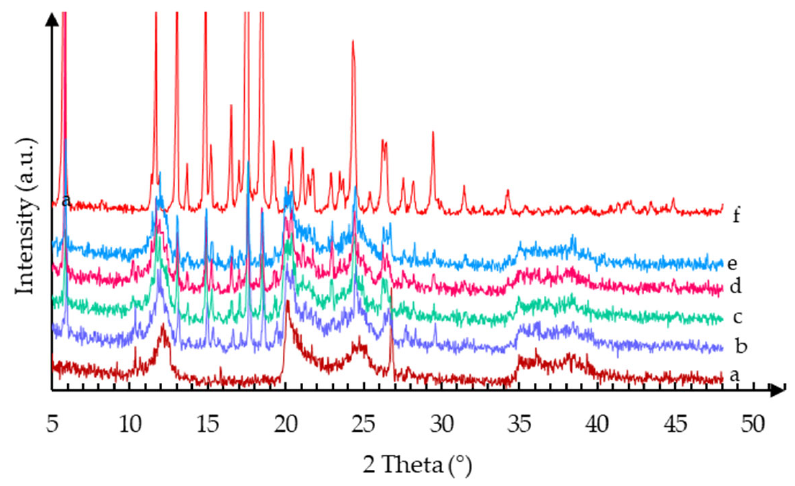
Figure 2. XRPD pattern of H (a), CH, (b) CH_HCl_8M (c), CH_H 2 SO 4 _0.5M (d) CH_NaOH_0.5M (e), and C (f).